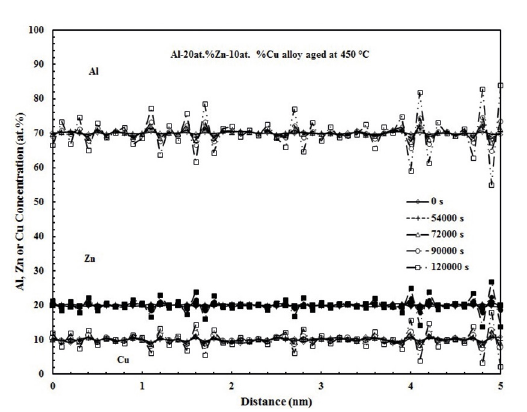
Figure 7. Al, Cu and Zn concentration profiles of the Al-20at.%Zn- 10at.%Cu aged at 450 °C for different